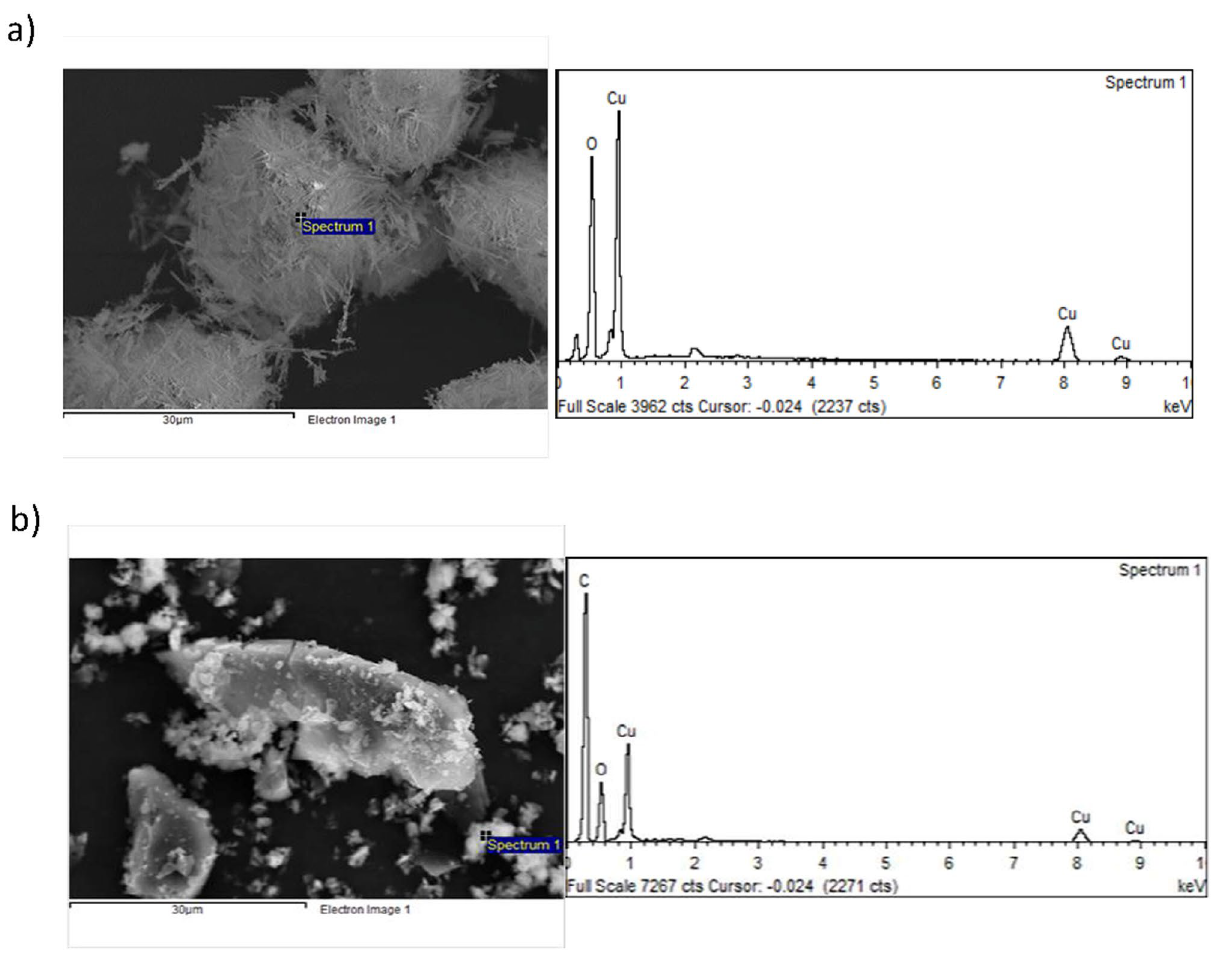
Figure 3. ( a ) SEM–EDS spectra of the Cu(OH) 2 -NWs, ( b ) SEM–EDS spectra of the Cu(OH) 2 -NWs-PVA-AC Nano-composite.